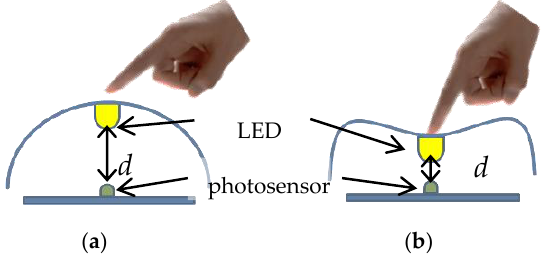
Figure 4. Difference between cases with and without force: ( a ) Case without force; ( b ) Case with force. The proposed interface can change sound volume. The measurement value from the acceleration sensor changes when the dancers move the grasping interface through their motions. The accelerometer measures acceleration with respect to the x , y , and z -axes. For noise reduction of accelerometer, we applied a smoothing filter which is based on moving window average of 10 samples. The acceleration values are sent to the computer via the Bluetooth module. The computer calculates three-dimensional (3D) acceleration vector length L using these values and the volume is determined by this length as